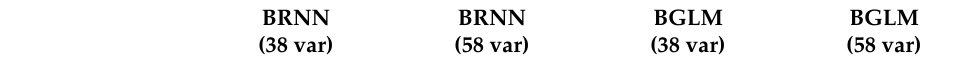
BRNN BRNN With 38 vars